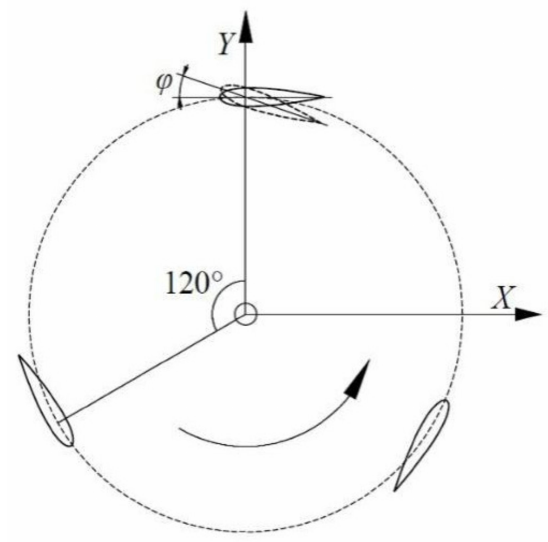
Figure 1. Schematic of H-Darrius